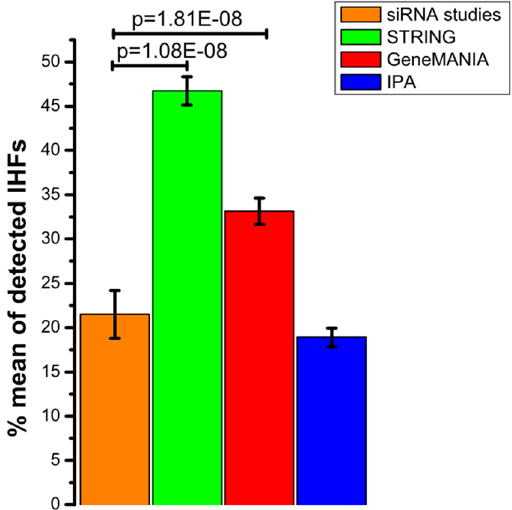
Figure 4. Comparison of siRNA experimental studies and network growing tools in detecting known